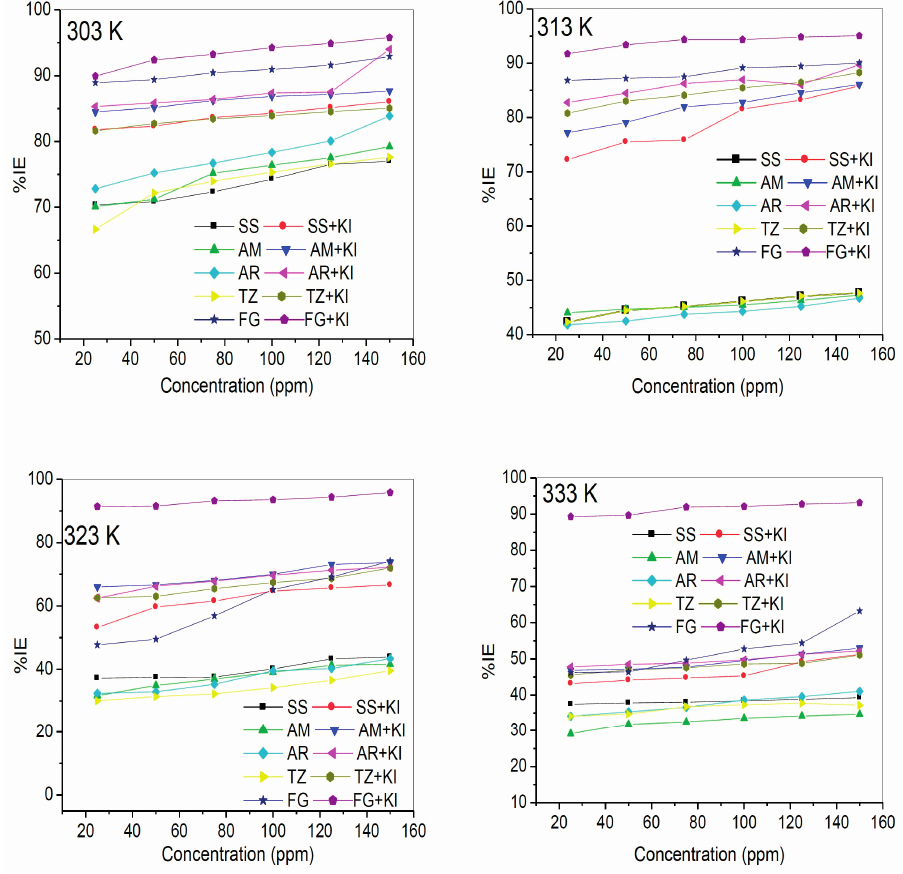
Figure 2. Inhibition efficiency against concentrations for the studied dyes without KI and with KI at 303–333